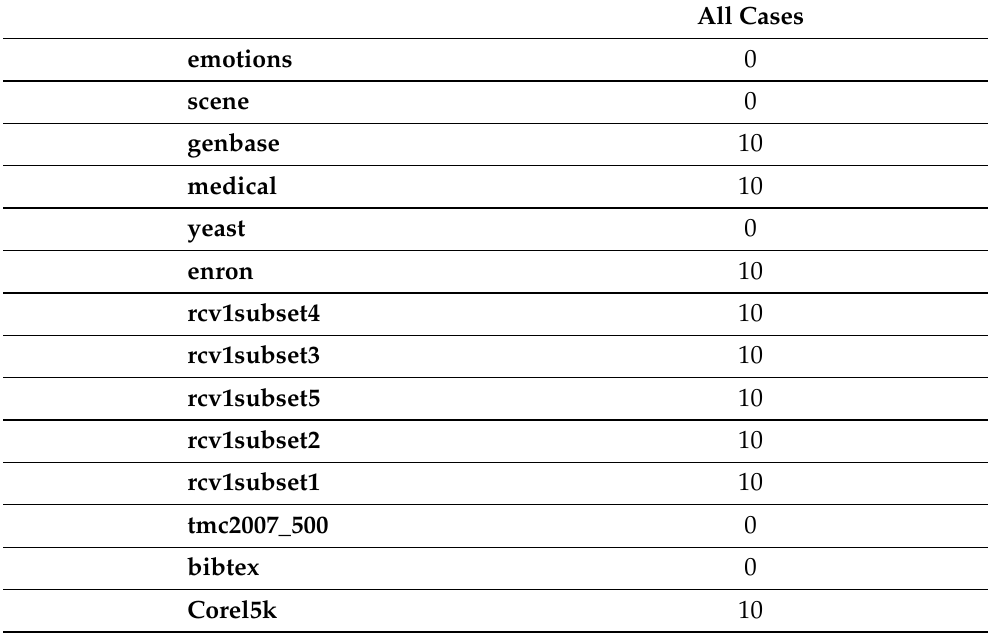
Table 6. Number of folds that contain at least one label with zero positive examples ( FZ ). All the splitting algorithms obtain the same